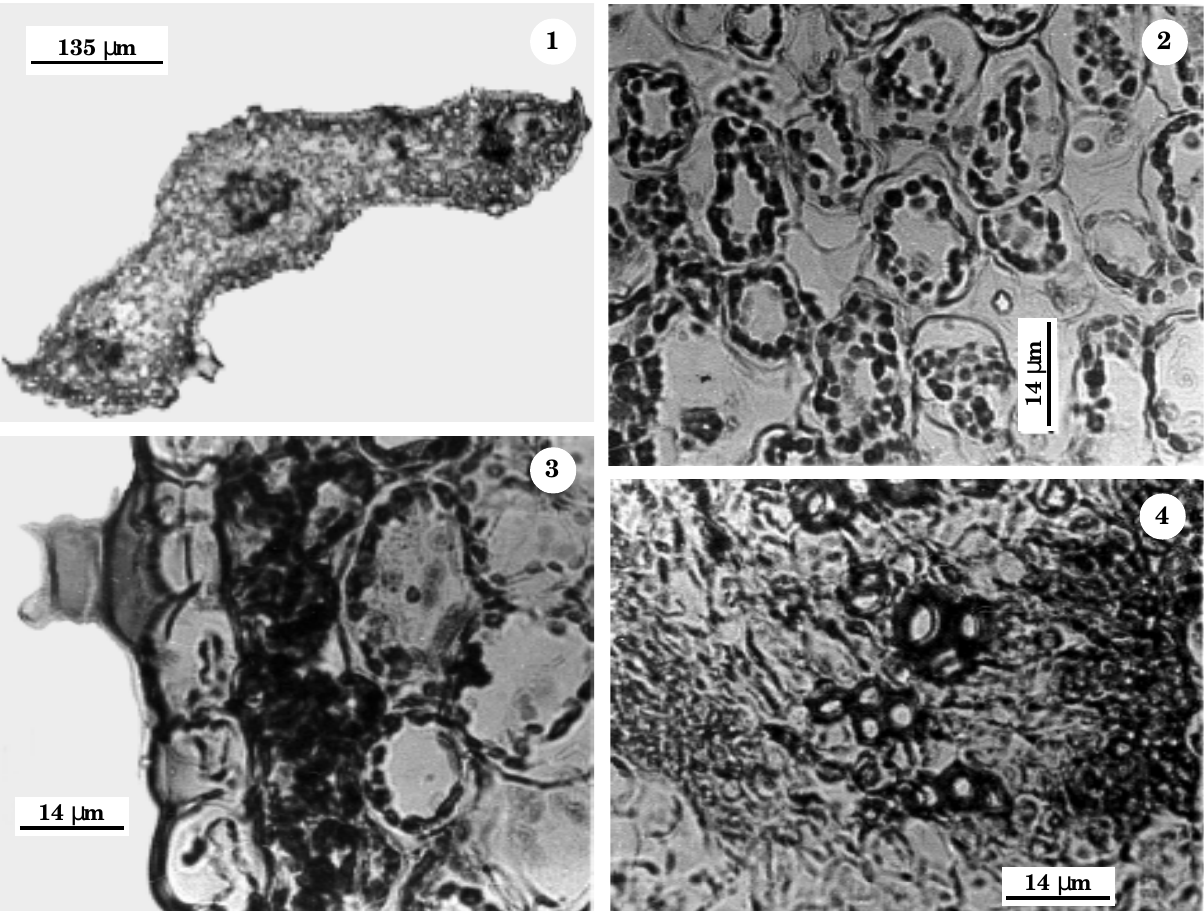
Fig. 1-4. Cross sections of sepal of Marmande tomato flower infected with TMV-M showing the general form of infected sepal (1), magnified part of mesophyll (2), magnified part of epidermis (3), magnified part showing xylem and phloem elements